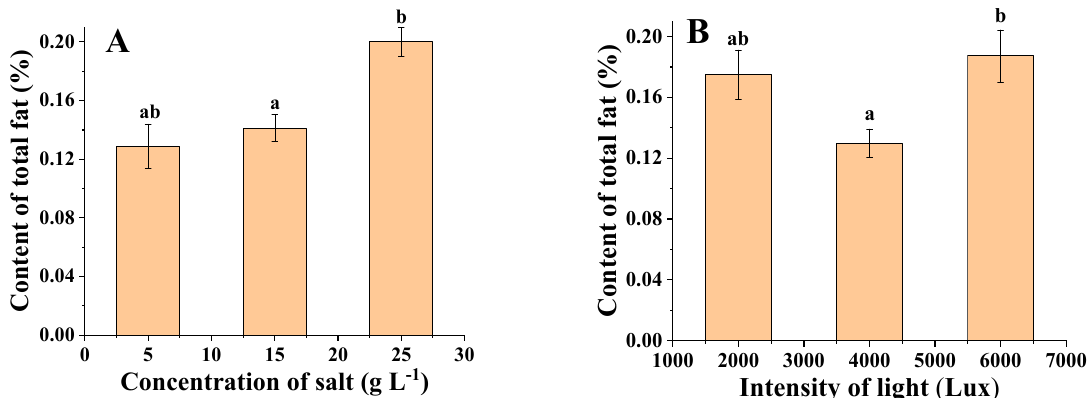
Figure 7. Triglyceride contents under different culture conditions of C. menegheniana MH2018001. ( A ) represents the oil content at different NaCl concentrations; ( B ) represents the oil content under different light conditions). Different letters indicate statistical difference between groups ( p < 0.05). The results are presented as mean ± SE ( n = 3).